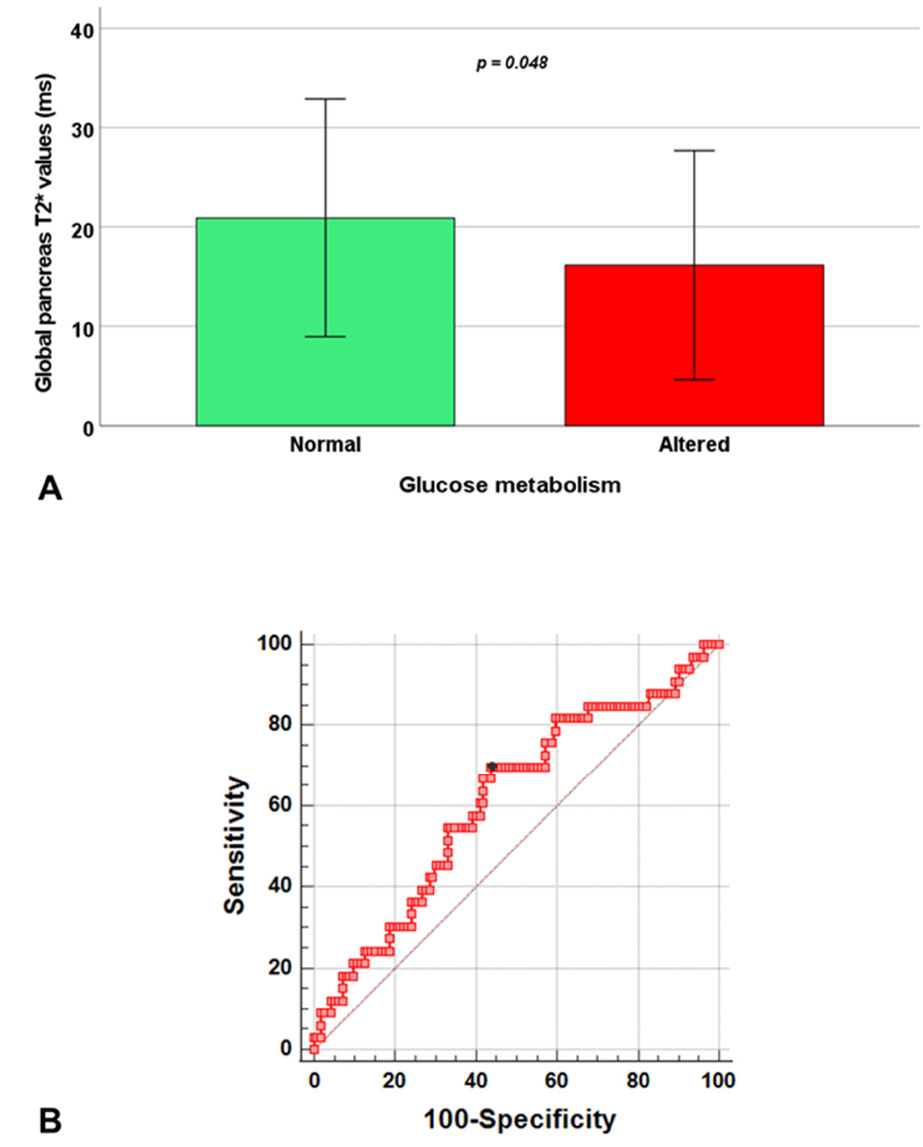
Figure 2. Association between global pancreas T2* values and glucose metabolism in RT-TI patients. ( A ) Global pancreas T2* values in patients with normal and altered glucose metabolism. ( B ) ROC curve analysis of global pancreas T2* values to predict an abnormal oral glucose tolerance test.